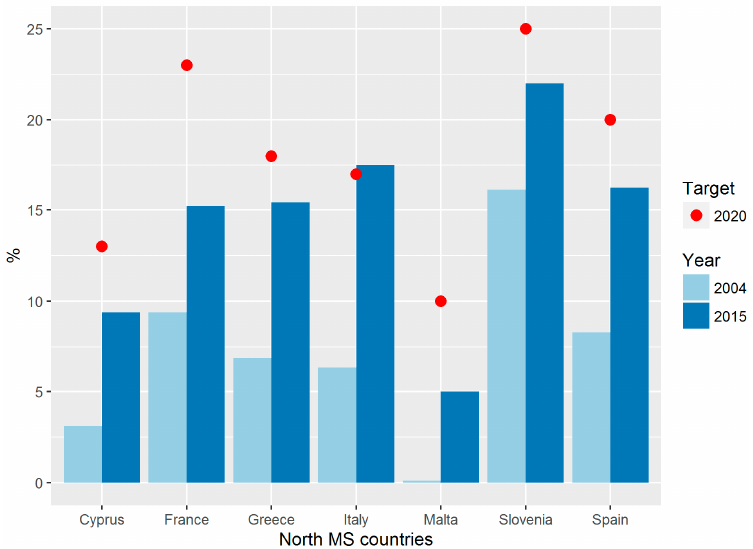
Figure 11. Overall share of energy from renewable sources (in % of gross final energy consumption) of the Northern Mediterranean Sea. Data from http://ec.europa.eu/eurostat/web/energy/data/shares.